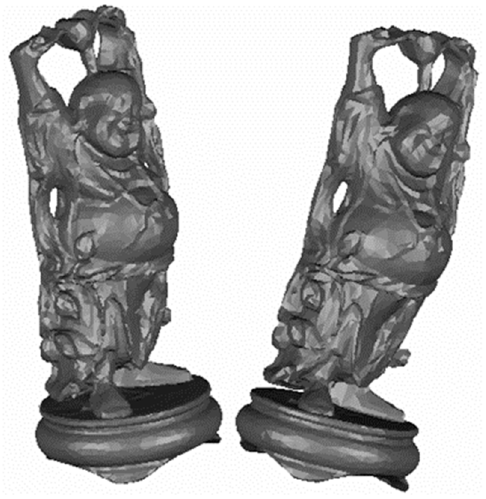
Figure 4. The Happy Buddha point cloud. Note that the point clouds are in ply format.